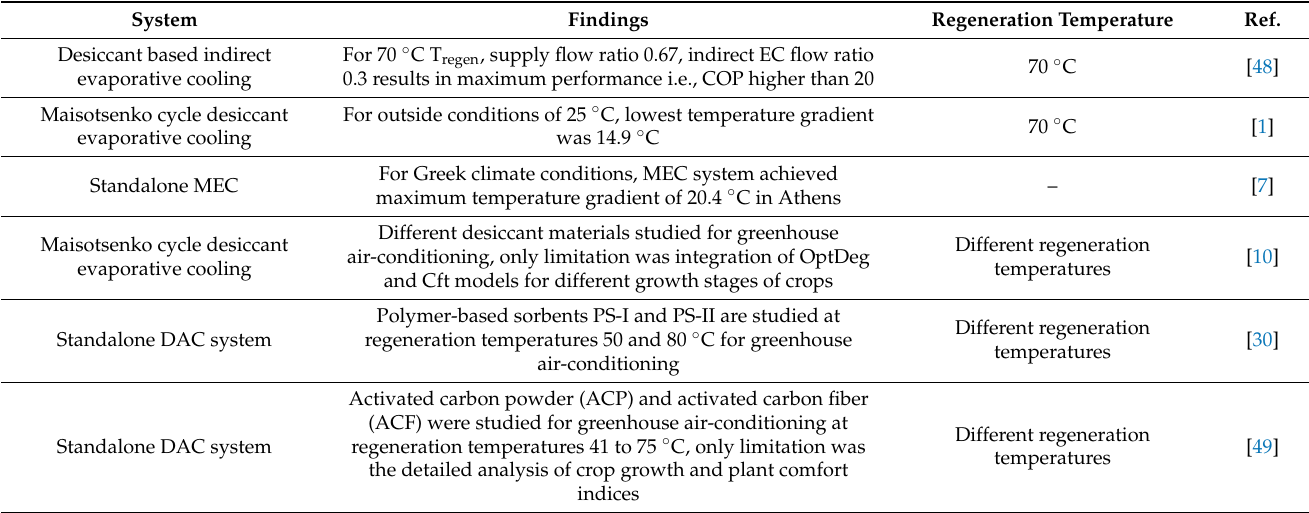
Table 1. Summary of different desiccant-based Maisotsenko cycle evaporative cooling systems for air-conditioning applica-